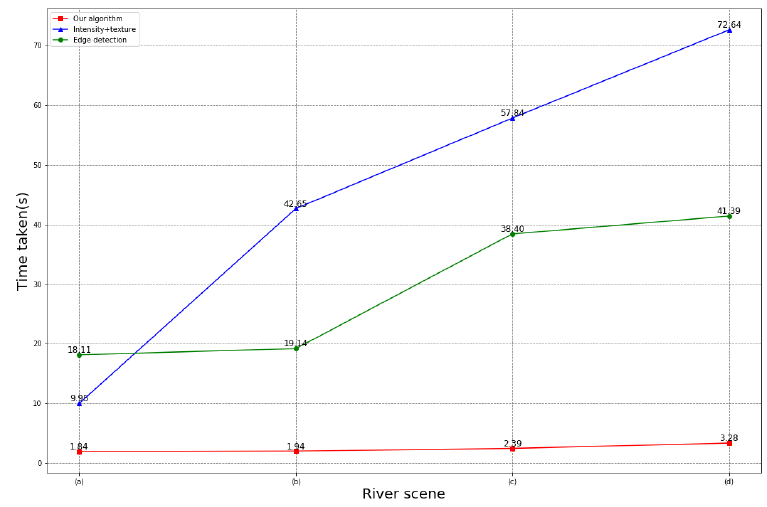
Figure 13. Speed of different methods in the complex